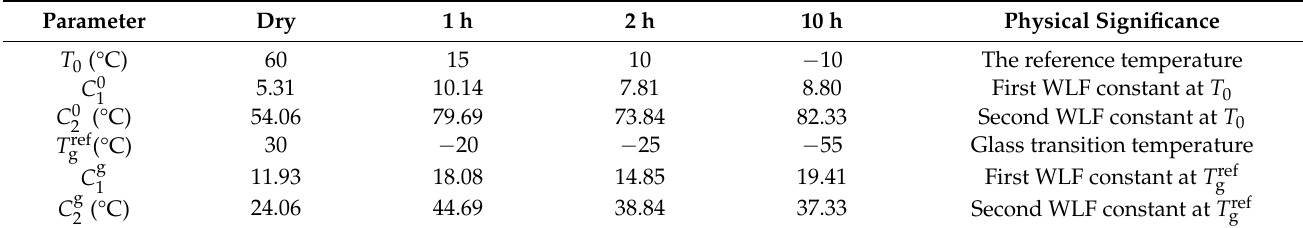
Table 3. Parameters of WLF constants for polymers with 20 wt.% crosslink